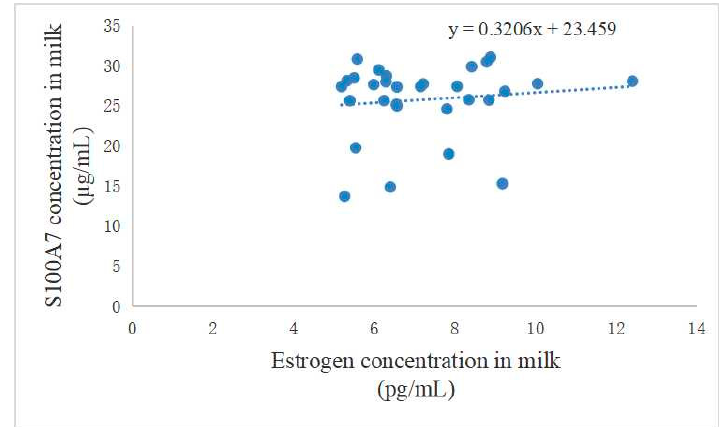
Figure 2. The relationship between estrogen and S100A7 abundance in milk.